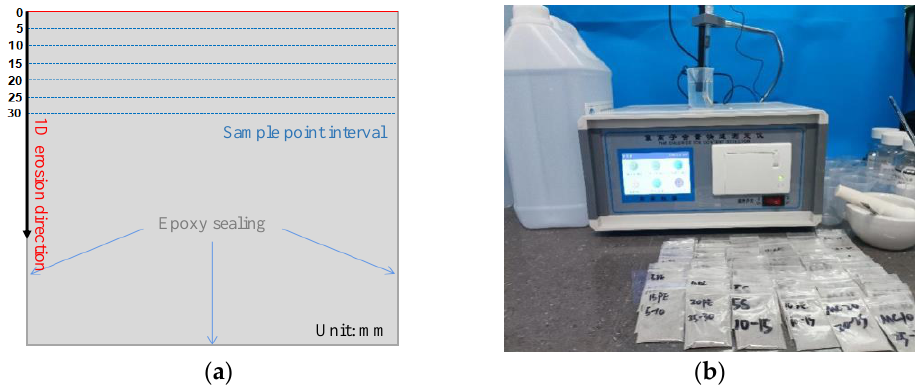
Figure 8. Chloride ion content detection. ( a ) Schematic diagram of split section ( b ) Chloride ion content detection